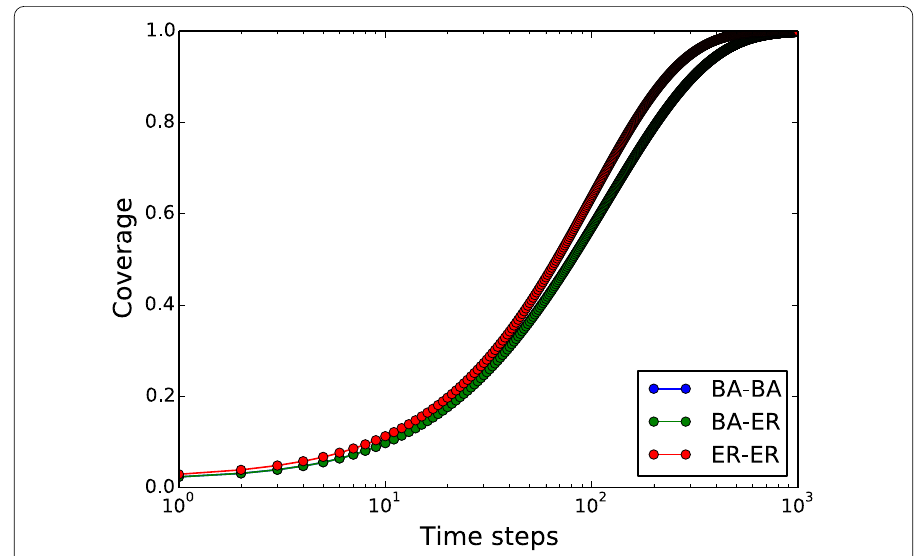
Figure 4 Coverage convergence of random multiplex networks. We consider three different configurations for a two layered multiplex: BA-BA, BA-ER, and ER-ER with the following settings: BA ( N = 100, E = 196), ER ( N = 100, E =